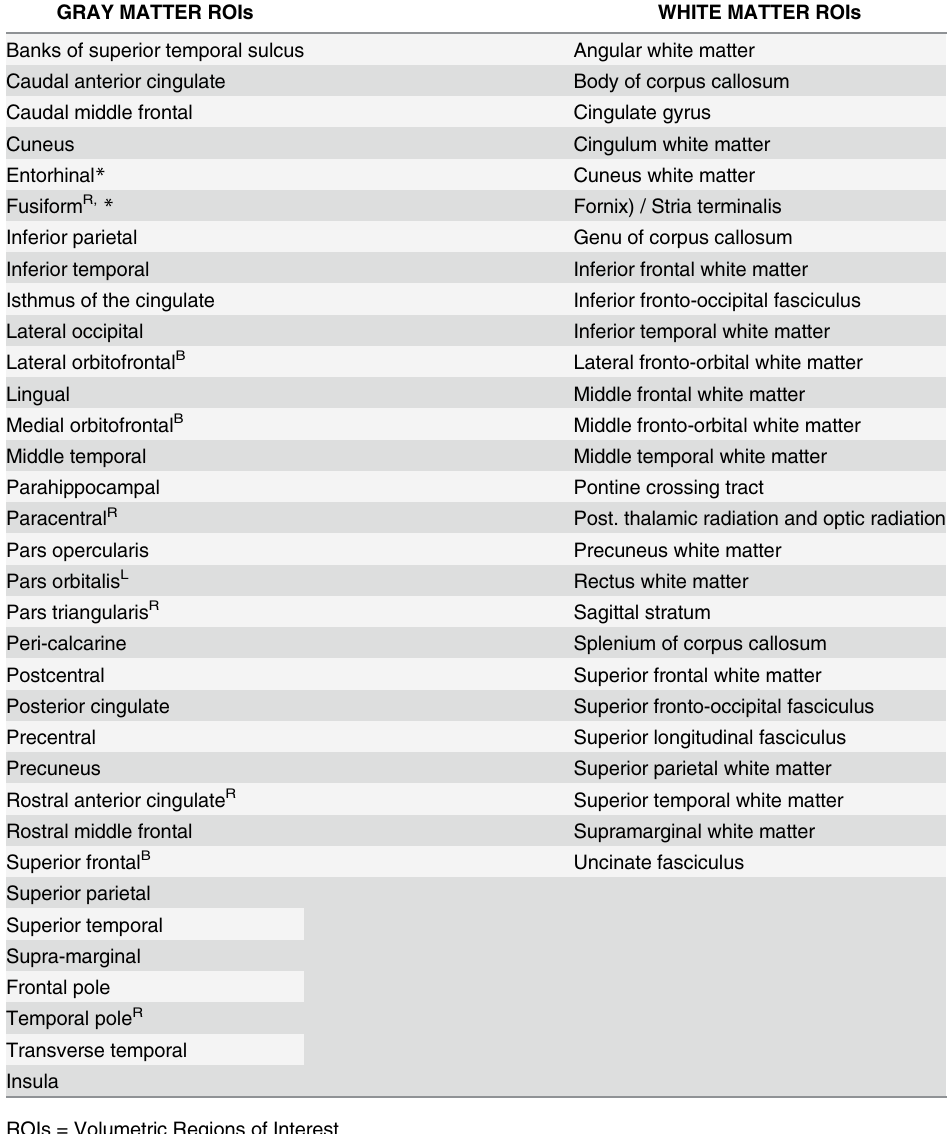
Table 1. Gray Matter Volumes (from the Desikan-Killiany brain atlas [25]) and White Matter Volumes (from the Johns Hopkins University atlas) A